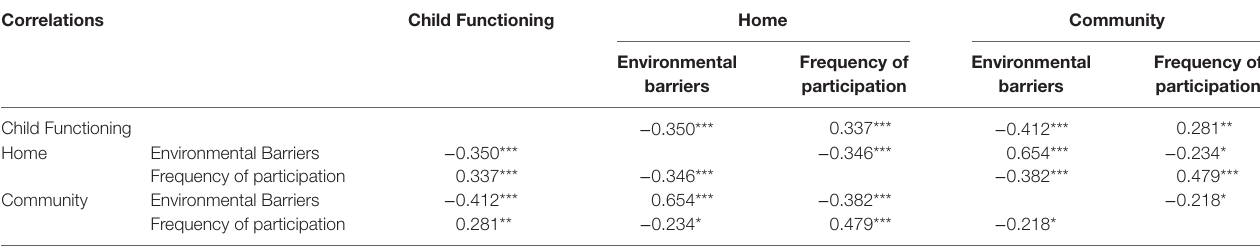
TaBle 3 | Correlations among variables: child functioning, environmental barriers, and the frequency of participation at home and in the community setting. correlations